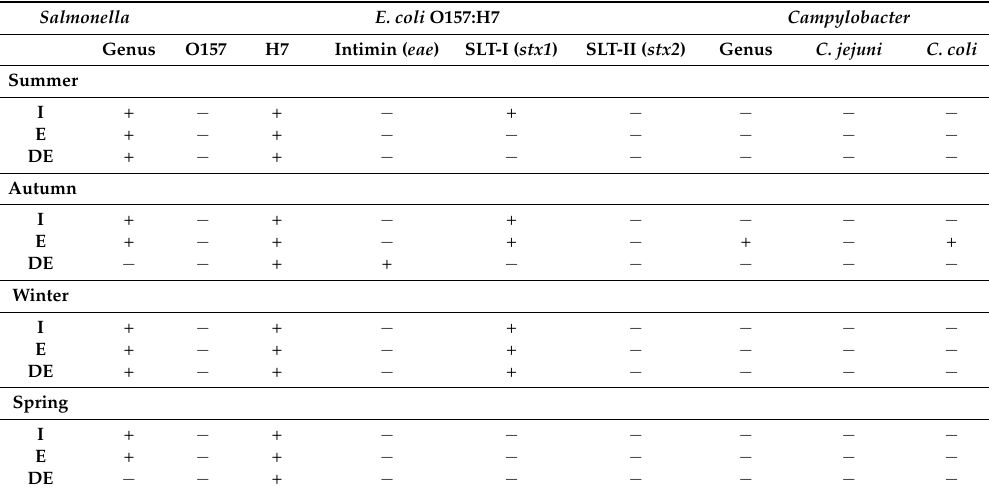
Table 3. Detection of Salmonella spp., E. coli O157:H7, E. coli virulence genes, and Campylobacter (spp., coli , and jejuni ) by the PCR method in a full-scale municipal wastewater treatment